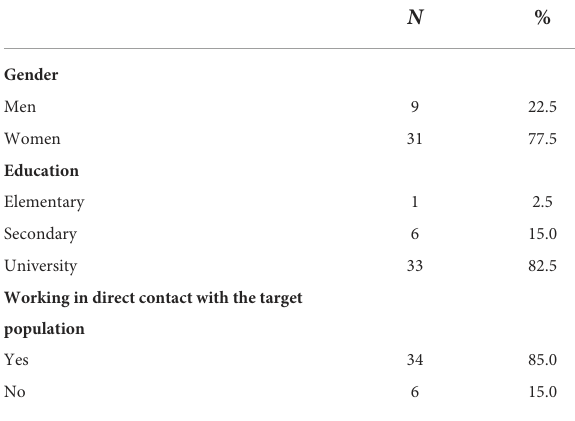
TABLE 1 Background characteristics of the